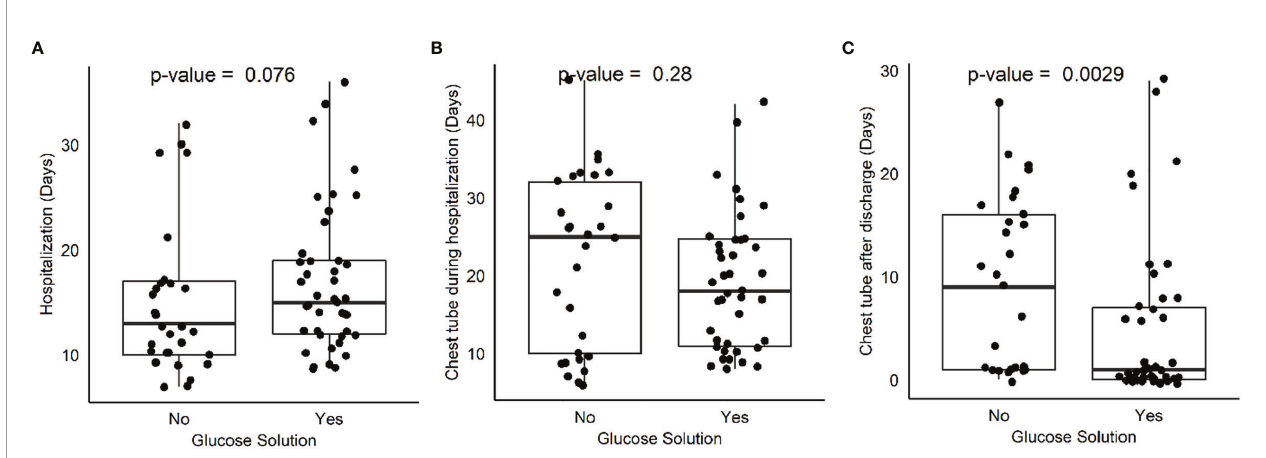
FIGURE 1 | Box plot comparing hospitalization days (A) , chest tube maintenance during hospitalization (B) and after discharge (C) between treatment and